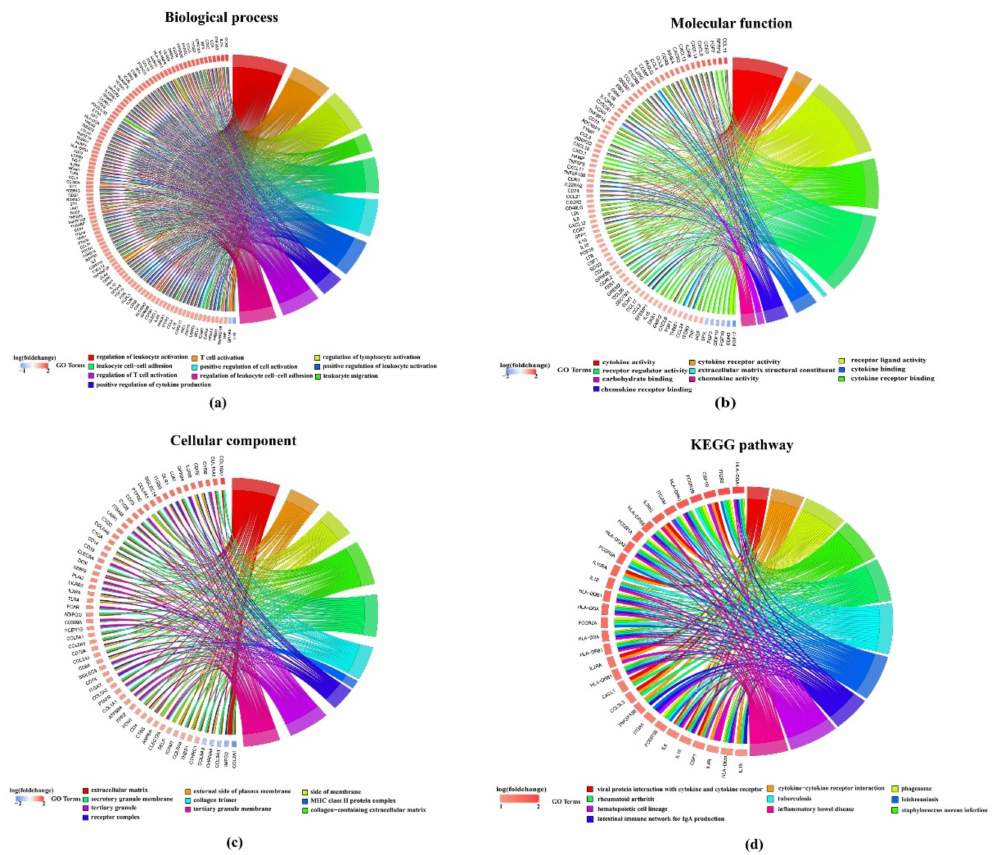
Figure 3. Kyoto Encyclopedia of Genes and Genomes (KEGG) and Gene Ontology (GO) functional enrichment analysis on 925 di ff erentially expressed genes (DEGs) with each top ten annotations in: ( a ) Biological process subsection of GO; ( b ) molecular function subsection of GO; ( c ) cellular component subsection of GO; ( d ) KEGG